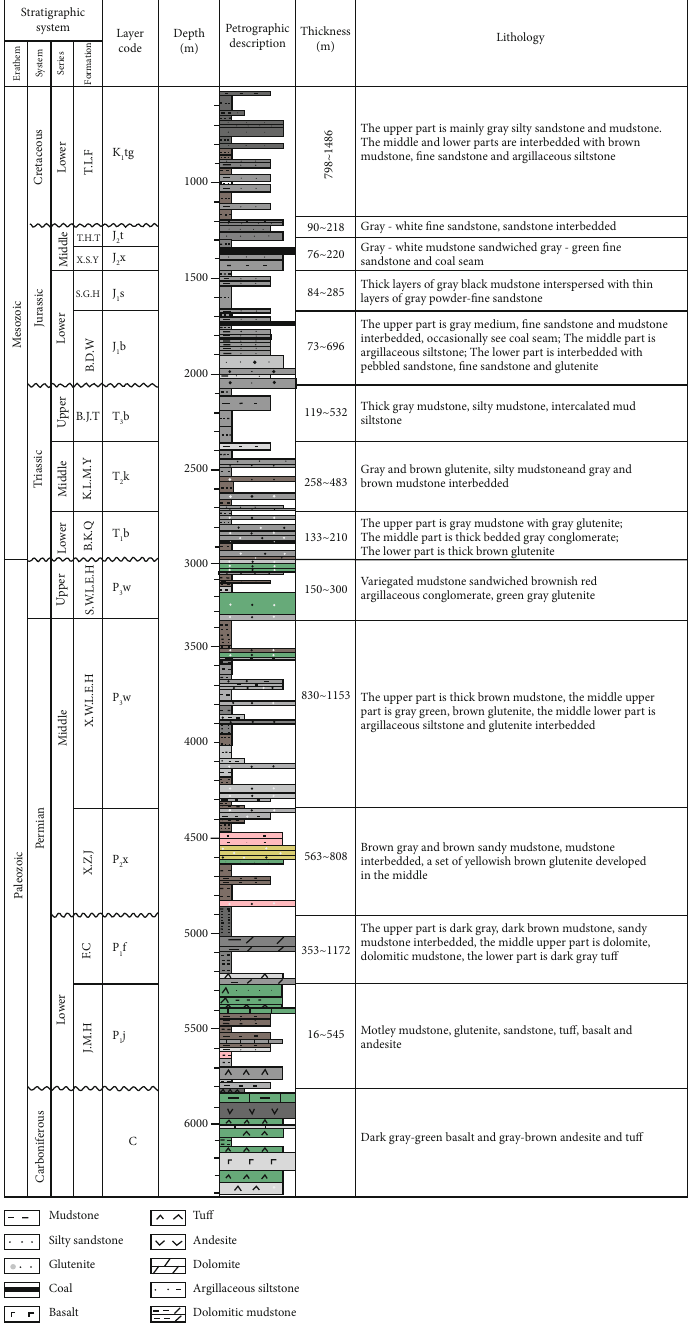
The upper part is mainly gray silty sandstone and mudstone. The middle and lower parts are interbedded with brown mudstone, fine sandstone and argillaceous siltstone